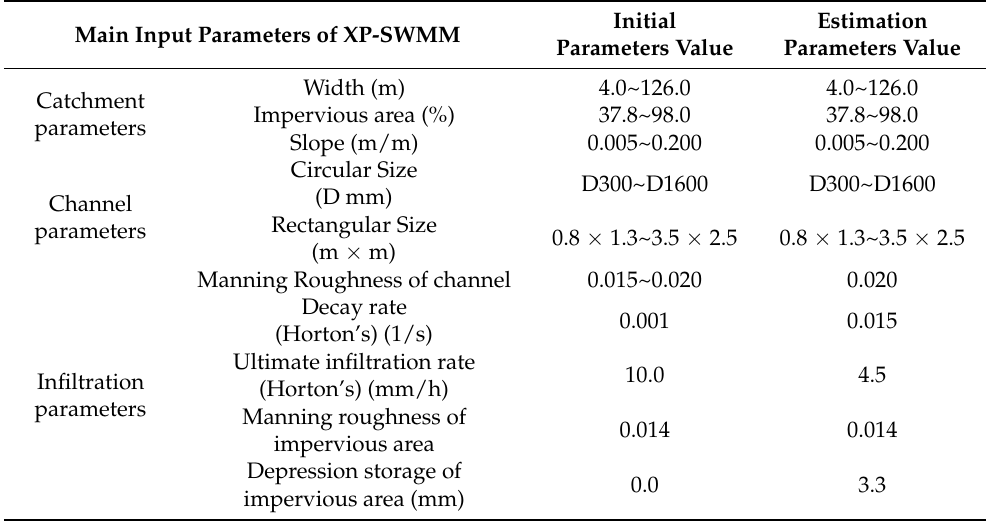
Table 5. Estimation results of the main parameters (Gildong